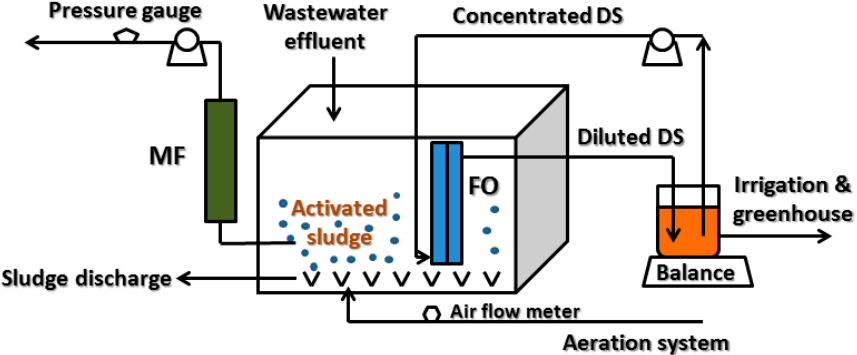
Figure 1. Flow diagram of the MF ‐ FDFO ‐ MBR hybrid system used in this study.